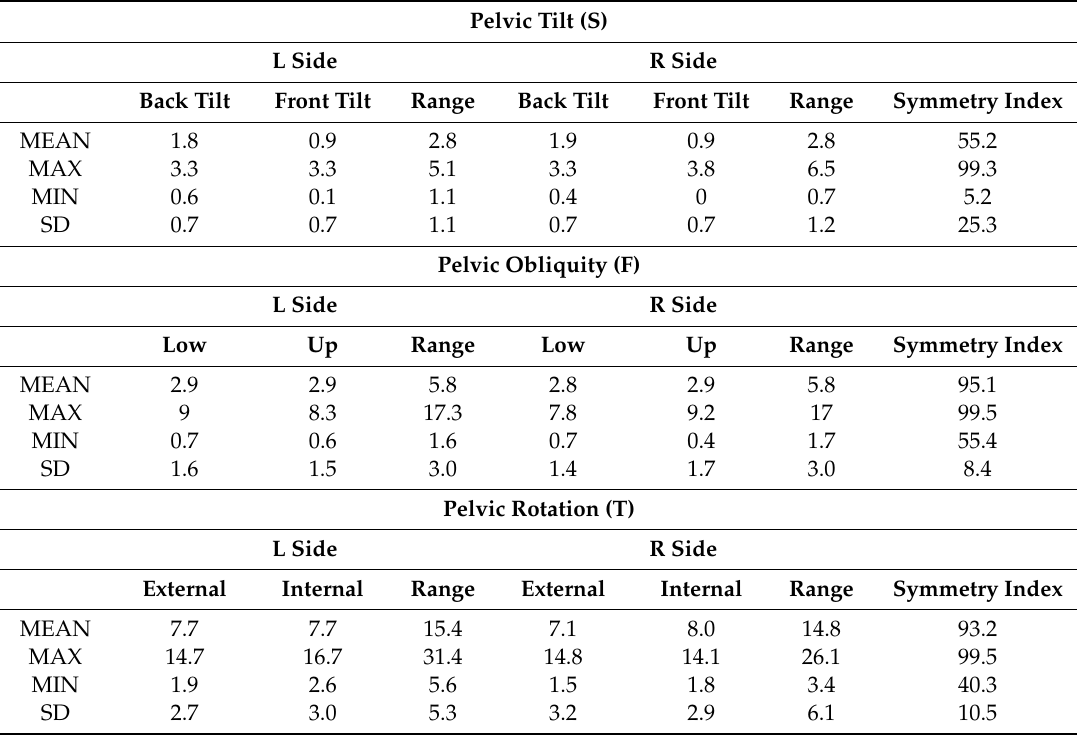
Table 1. Range of motion, symmetry index and descriptive statistics of pelvic